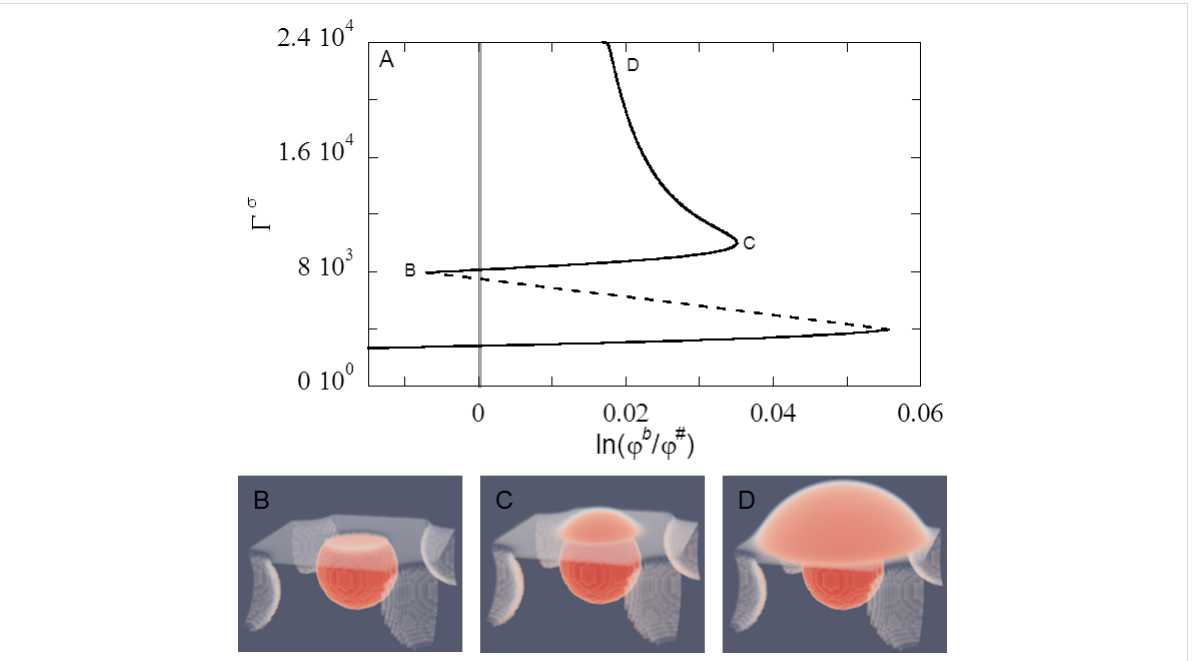
Figure 7: Liquid condensation in hydrophilic inverse opal ( d = 31, s = 88, t = 44, m = 3, n = 1, h = 25 ( c = 0.8)). A) Excess adsorbed amount of the liquid component in the system as a function of the volume fraction of the liquid normalised by the binodal value in lin–ln coordinates. The dashed part represents not the true part of the isotherm but rather connects two states, before the condensation of a pocket and after the condensation. The dotted, vertical line is at the bulk binodal φ # . The labels along the isotherm refer to the snapshot colour-coded density distributions given in panels B, C, D. Red is the high-density liquid phase, white is the low-density (gas)